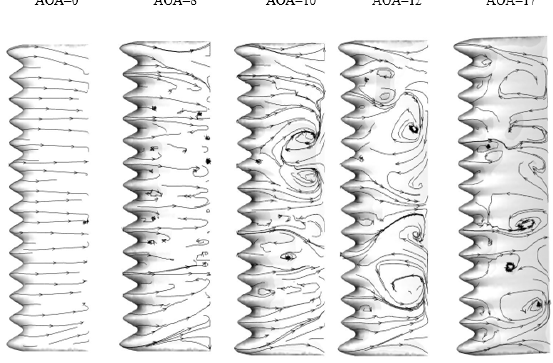
Figure 12. Streamlines for different angles of attack at the suction side of the wavy